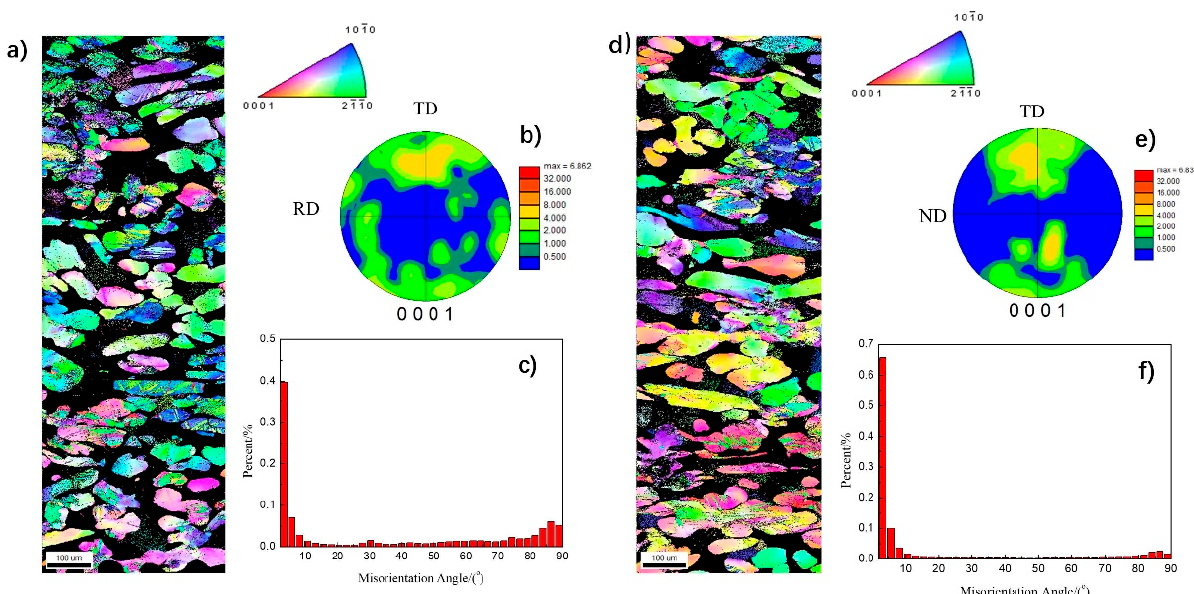
Figure 3. EBSD analysis results of the as-rolled plates. ( a – c ) demonstrate the EBSD image observed on the ND plane, the corresponding {0001}-polar figure and grain orientation difference diagram, respectively. ( d – f ) shows results for the RD plane.